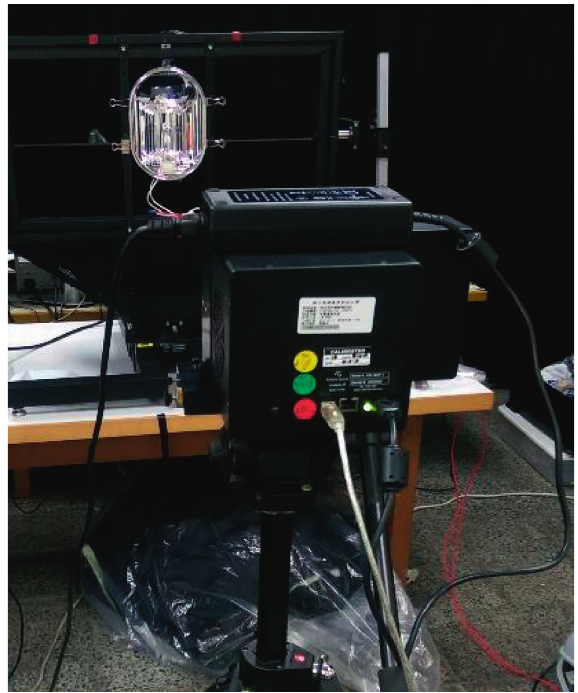
Figure 12: The street light measurement setup using an imaging